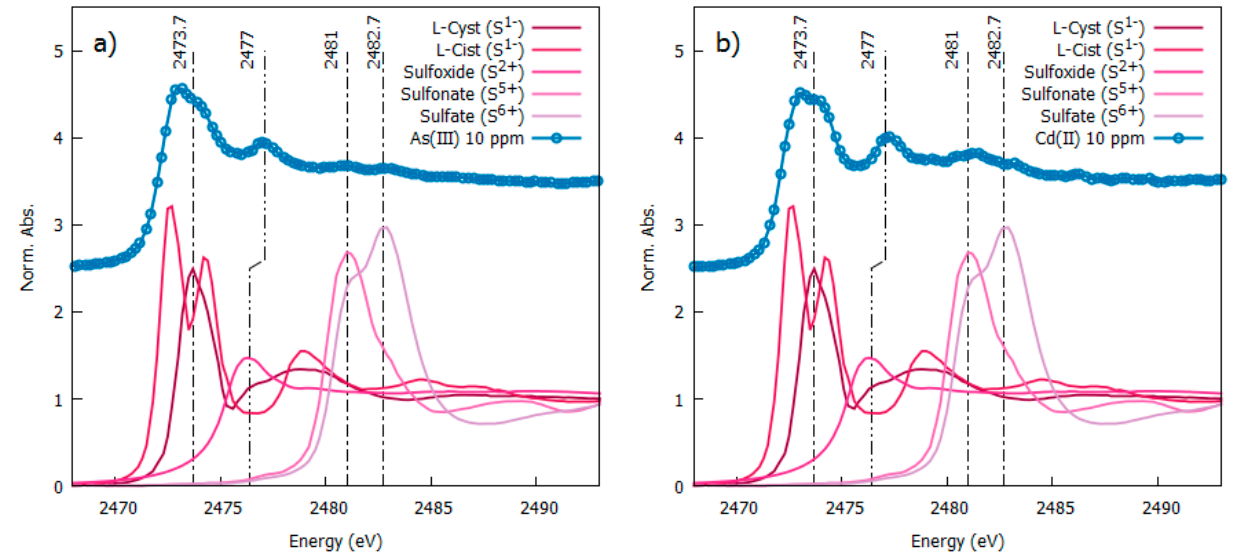
Figure 7. S-K edged spectra measured from 10 ppm As(III) left panel ( a ) and Cd(II)-right panel ( b ) loaded AgNP (vertically shifted fr clarity) in comparison with S-K-edge XANES spectra from reference sulphur compounds [23].